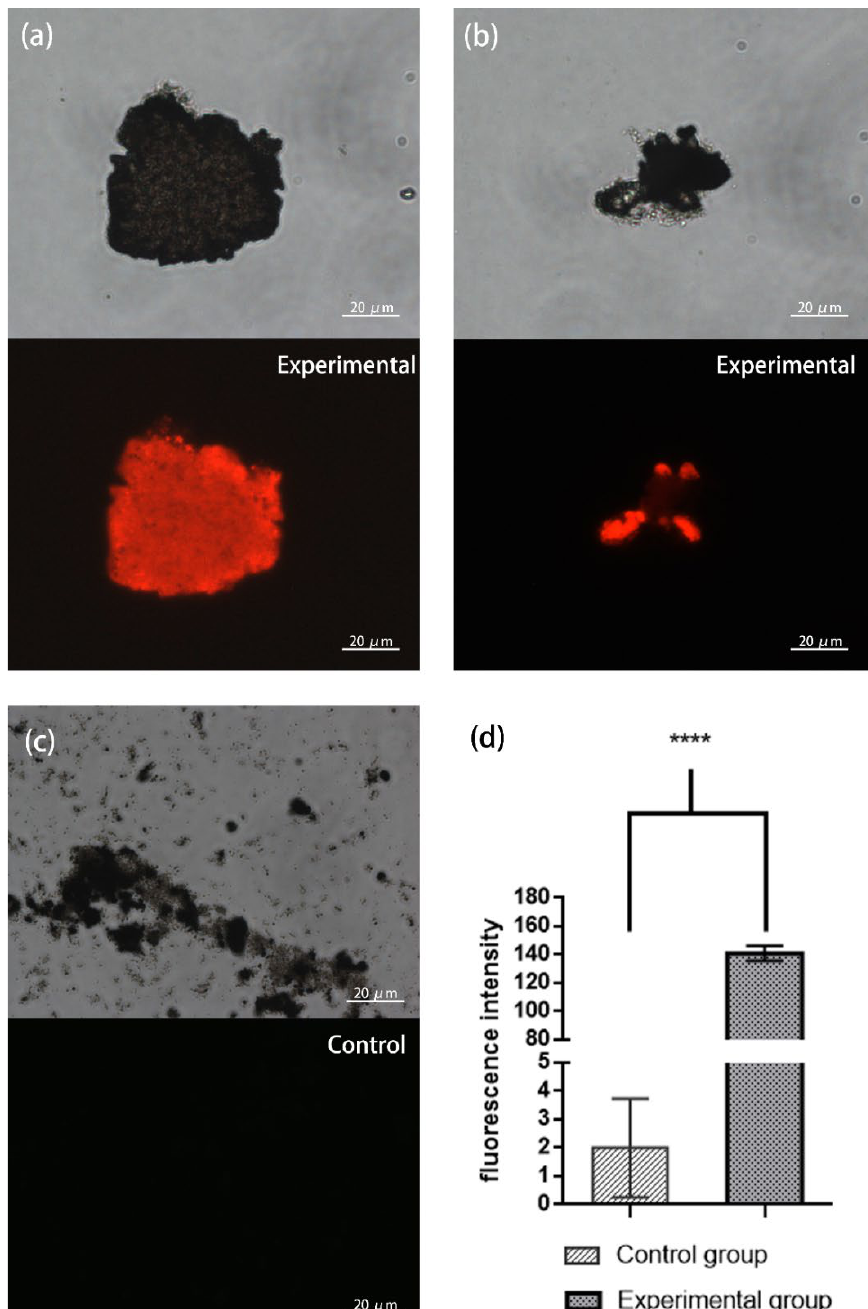
Figure 5. IMB after capturing the SARS-CoV-2 S-PS: ( a , b ) fluorescence microscope photos of the experimental group; ( c ) fluorescence microscope photos of the control group; ( d ) fluorescence intensity of experimental group and control group measured by microplate reader (**** p <